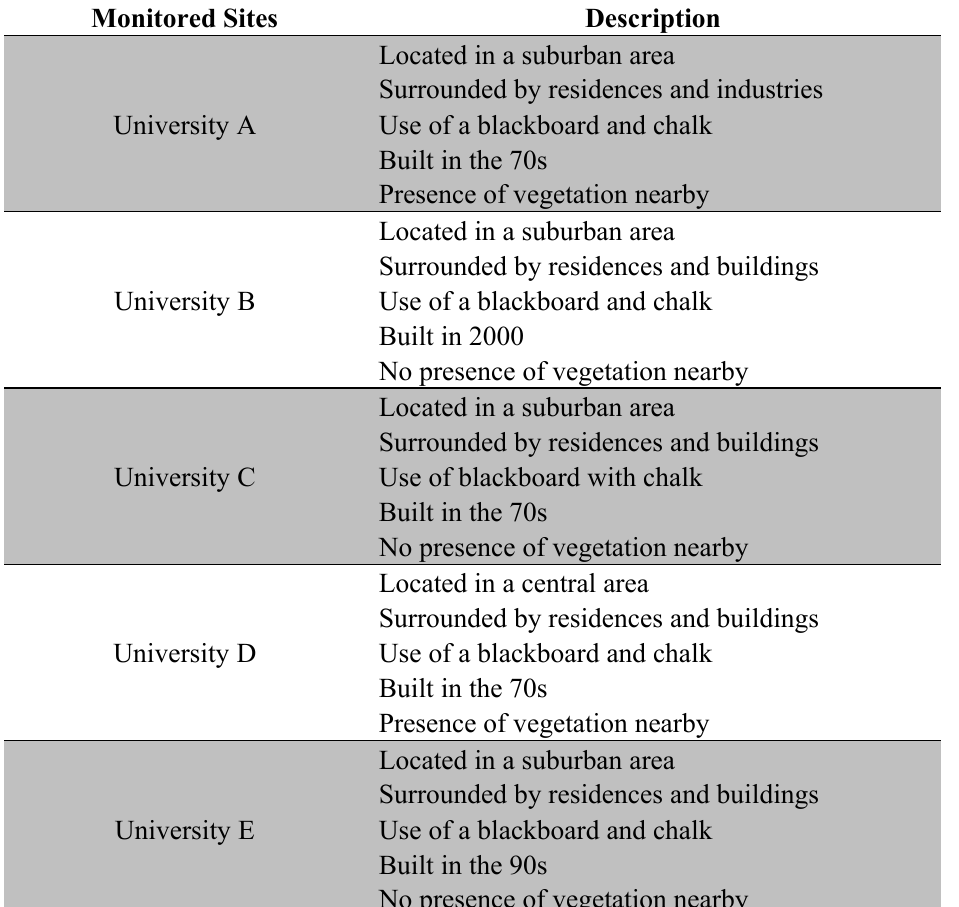
Table 1. Characteristics of the studied